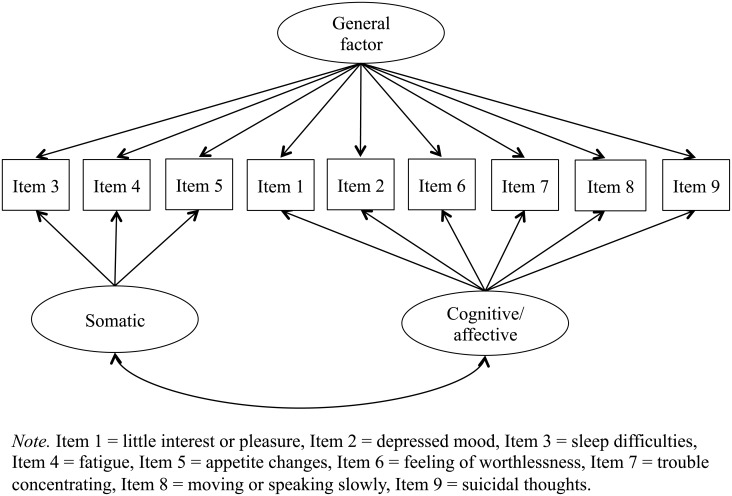
Bi-factor model.